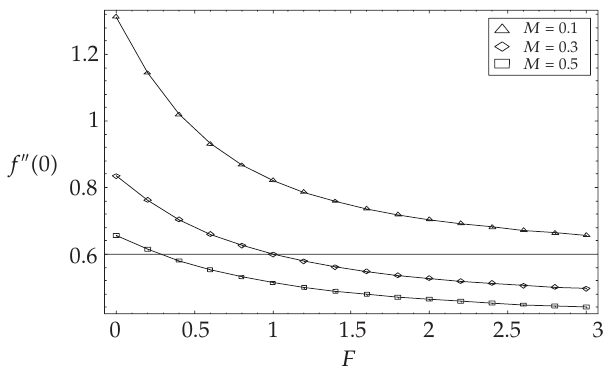
Figure 4.2 . Variation of f (cid:6)(cid:6) ( 0 ) with F and M